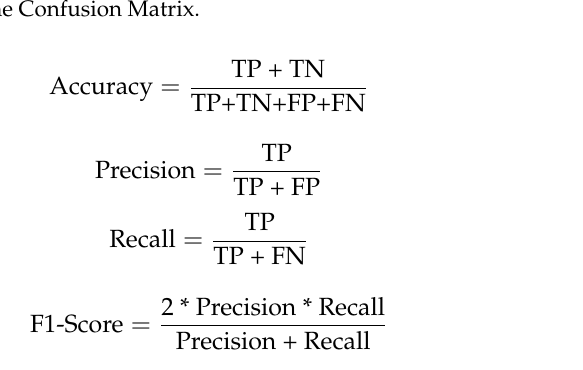
Figure 4. The structure of the Confusion Matrix.